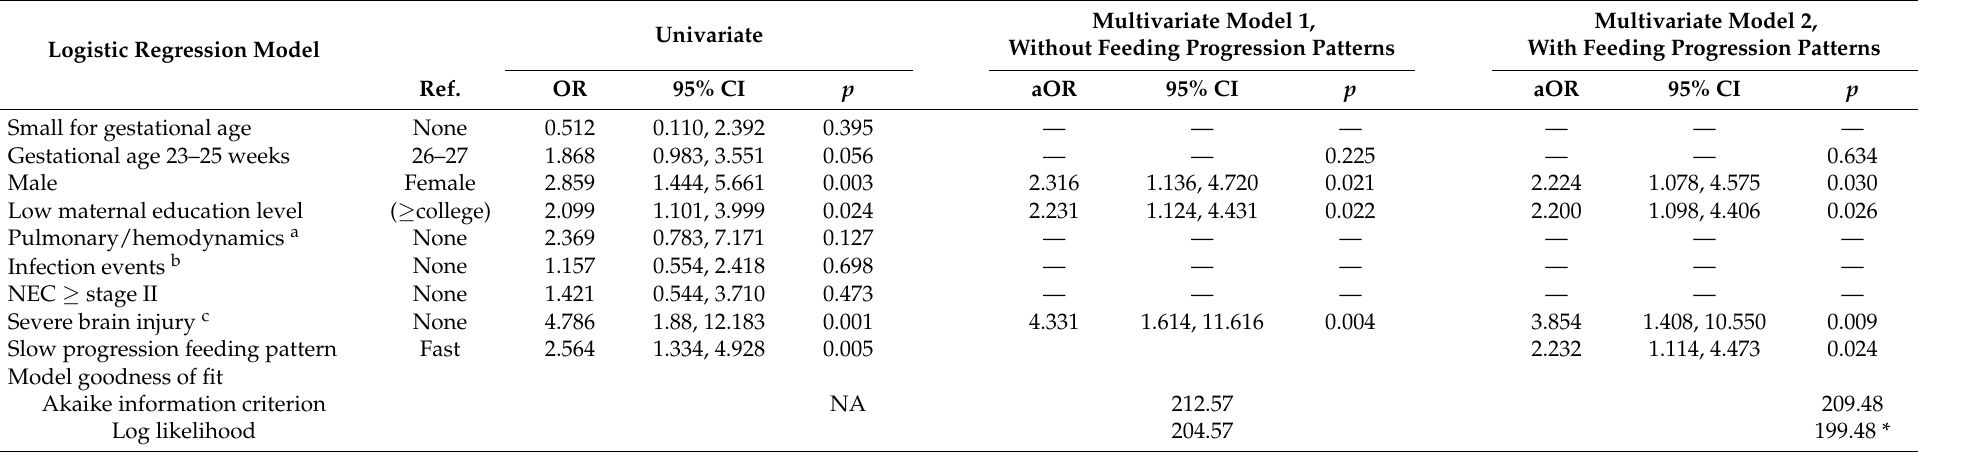
Table 3. Logistic regression analysis for early-life medical risks and feeding patterns associated with neurodevelopmental impairment outcomes at corrected age 24